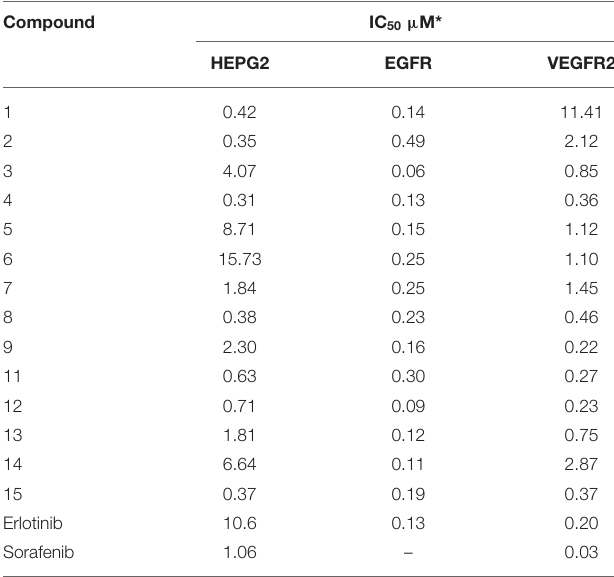
0.211 Å, respectively, with docking score (S = − 18.11 and − 17.56 TABLE 1 | In vitro anticancer activity against HEPG2 cell line and in vitro EGFR and VEGFR2 inhibitory activity for the synthesized compounds 1 – 14 . kcal/mol, Compound IC 50 µ M* HEPG2 EGFR VEGFR2